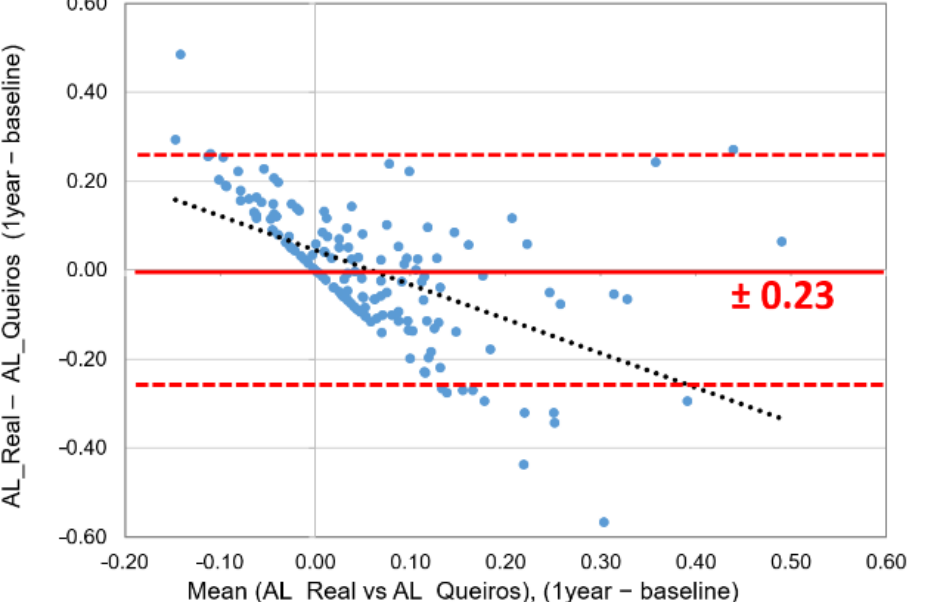
Figure 2. Bland–Altman plot for the 1-year differences between the real measured value of AL and this study.